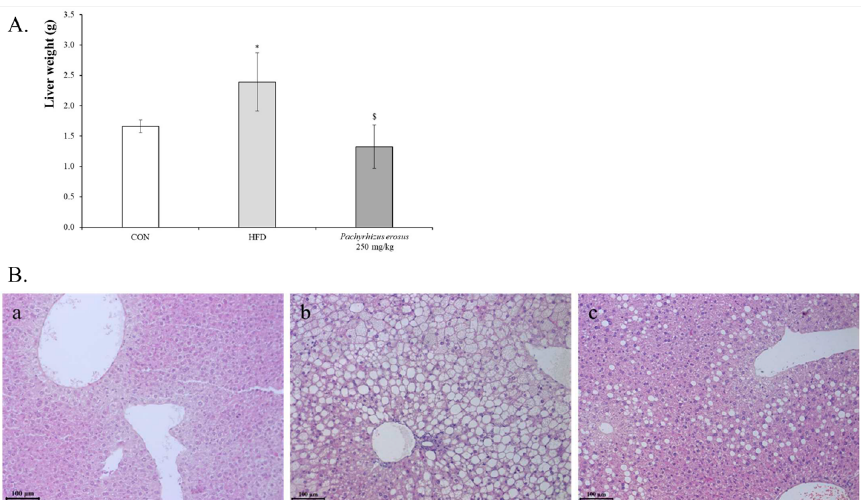
treatment group was the highest between the three groups, such as the control, HFD group, and P. erosus treatment group, although the gap in liver weight between the control and the P. erosus treatment group was very slight. Table in Figure 4A. The liver weight. The results are described as mean ± standard deviation. N = 12. * p < 0.05 vs. control; $ p < 0.05 vs. HFD-induced obesity. ( B ) HFD feeding induced lipid droplet accumulation in the liver, but P. erosus treatment could prevent their accumulation. ( a ) control; ( b ) high-fat diet group; ( c ) 250 mg/kg P. erosus treatment group. Scale bar, 100 µ m. Magnification, ×